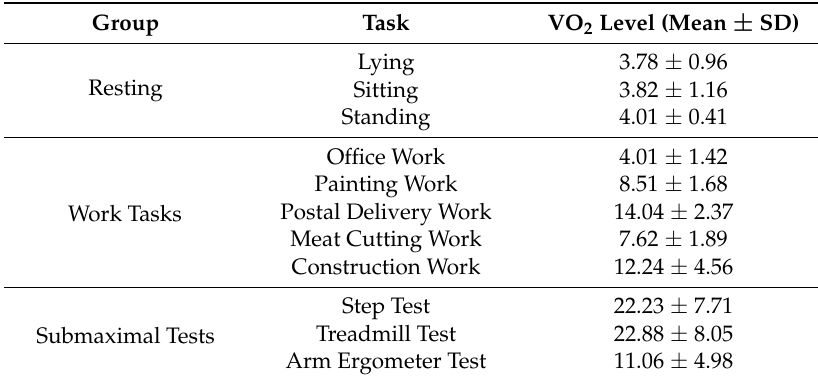
Table 4. A summary of tasks performed during the experiments and corresponding mean VO 2 level (mL/min/kg) of the 11